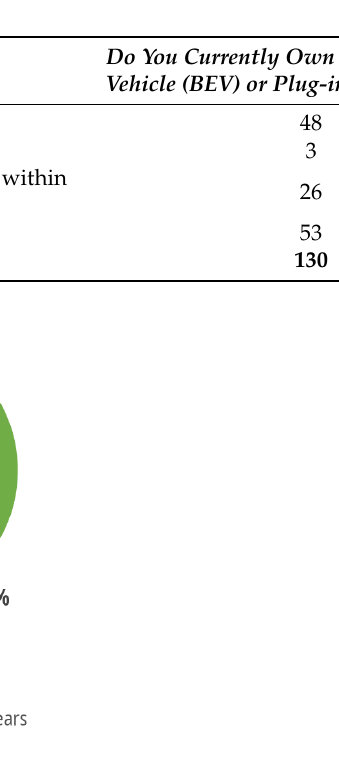
51 Figure A4. Responses to questions (5) and (7) expressed as a percentage of responders.